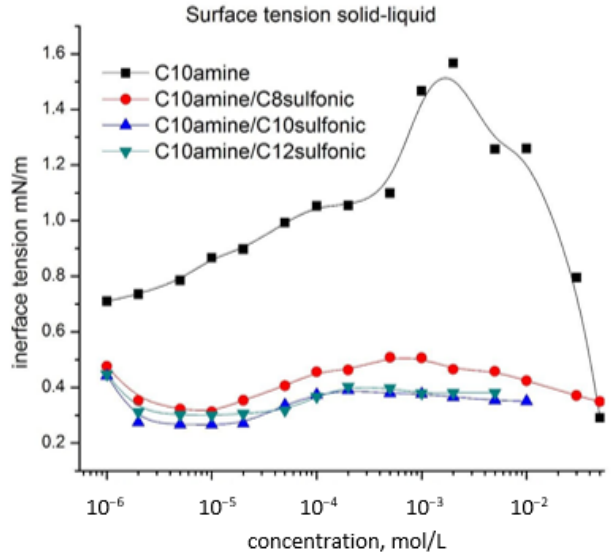
Figure 6. Calculated surface tension vs. concentration for di ff erent systems of solid / liquid surface.